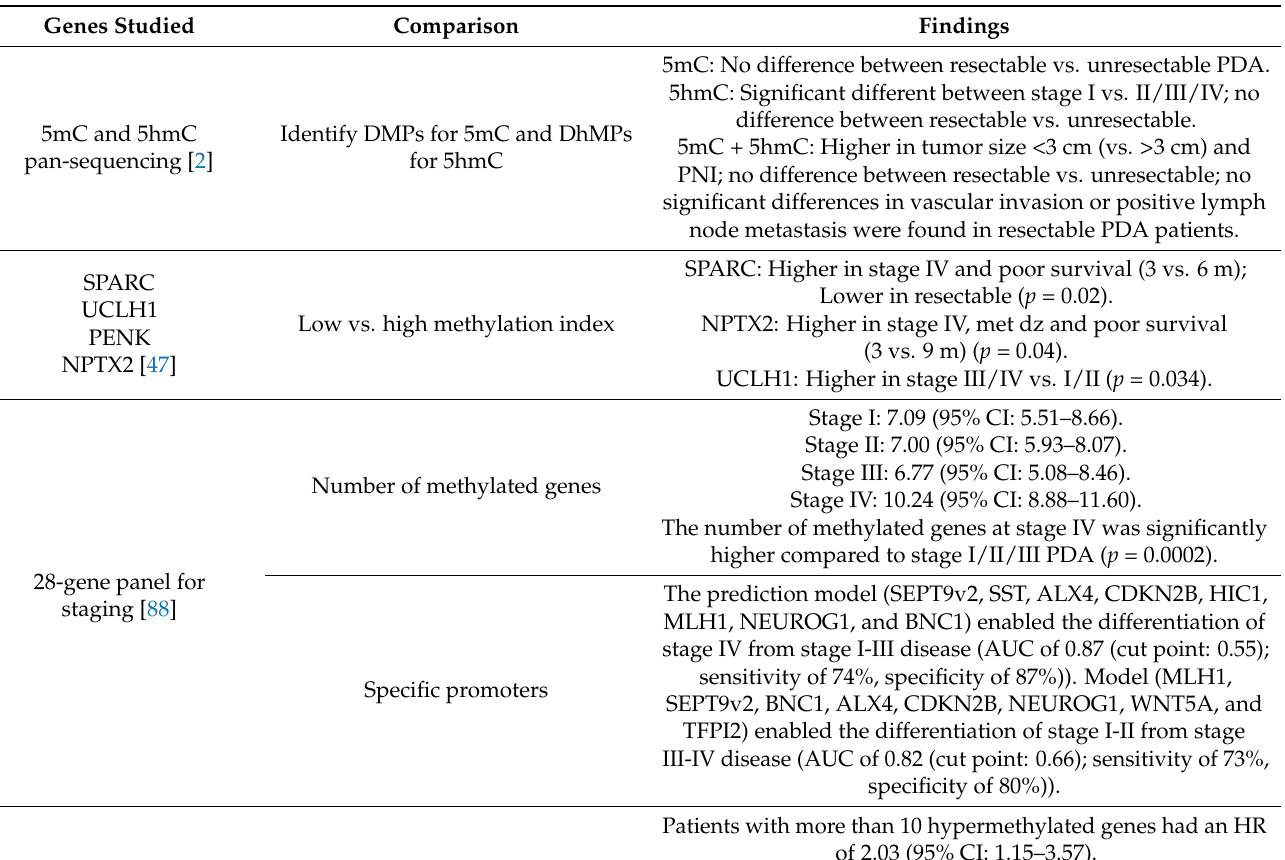
Table 3. Summary of studies examining epigenetic markers in cfDNA relating to prognosis of patients with